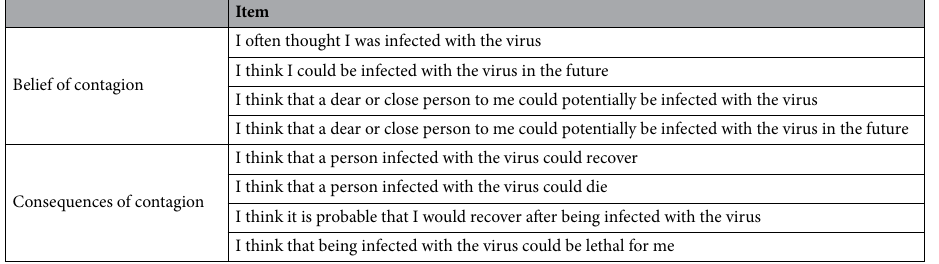
Table 3. Fear for COVID-19 Questionnaire: item descriptions and pattern matrix of the